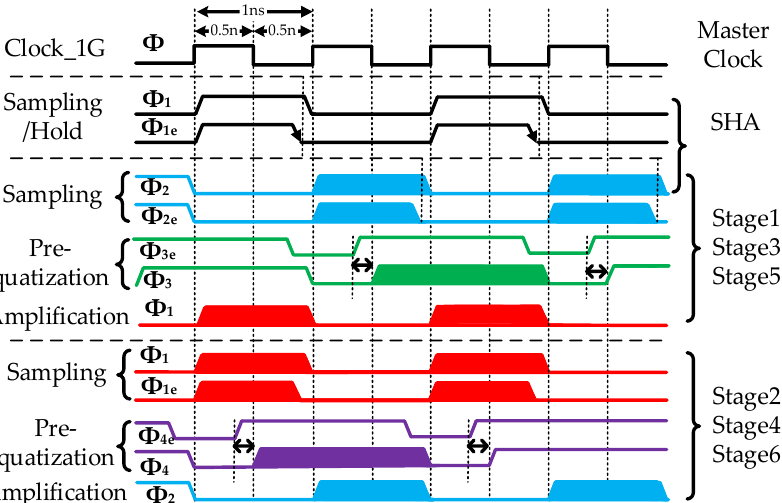
Figure 3. Pre-quantization timing, including sampling, pre-quantization, and amplification phase. Detailed timing is provided for SHA, Stage1~Stage6. For Stage1, Stage3 and Stage5, Ф 1 , Ф 1e , and Ф 2 are provided to sample and amplify. For Stage2, Stage4, and Stage6, Ф 3 and Ф 3e are designed for comparators. Ф 2 , Ф 2e , and Ф 1 are provided to sample and amplify. Ф 4 and Ф 4e are designed for comparators.